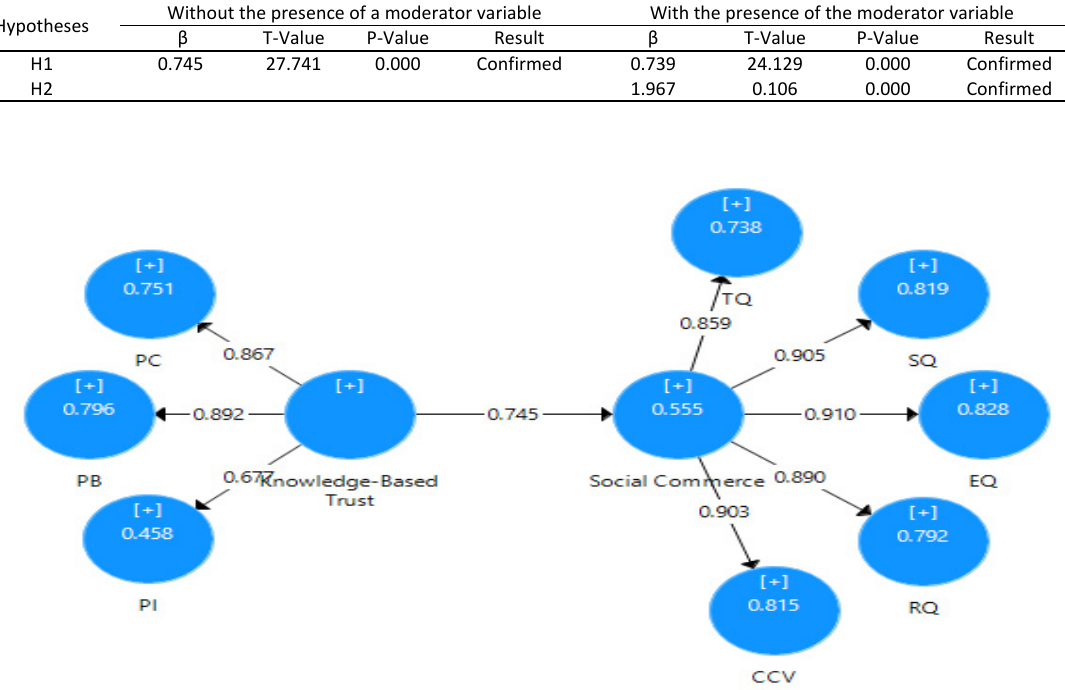
Fig. 2: Causal relationship between variables in the standard estimation mode